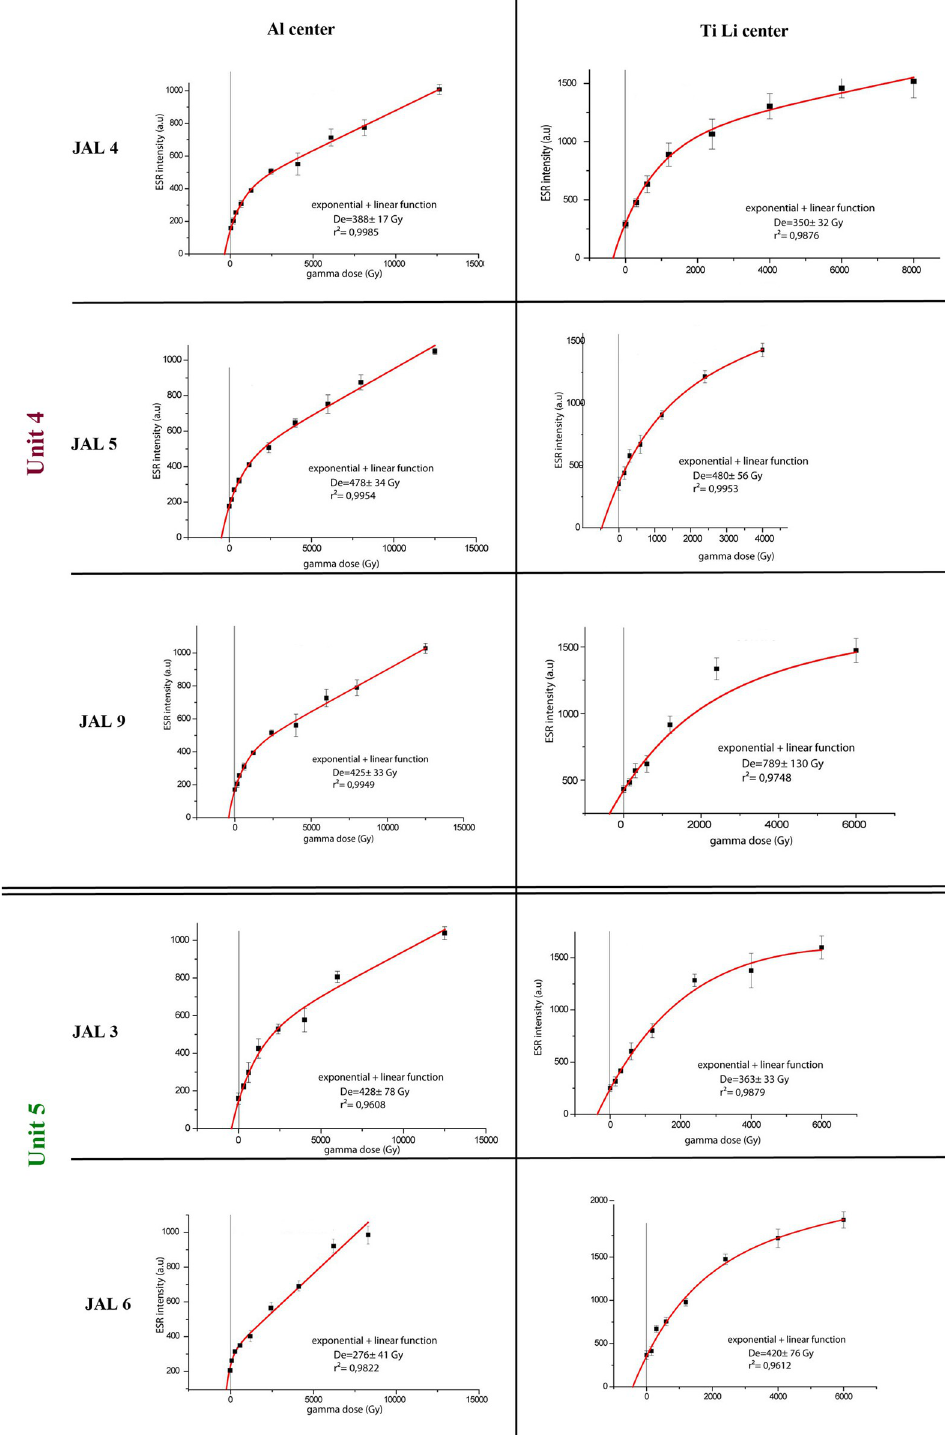
Fig 8. Growth curves of the ESR samples. Al centers are presented on the left. Ti Li centers are on the right.